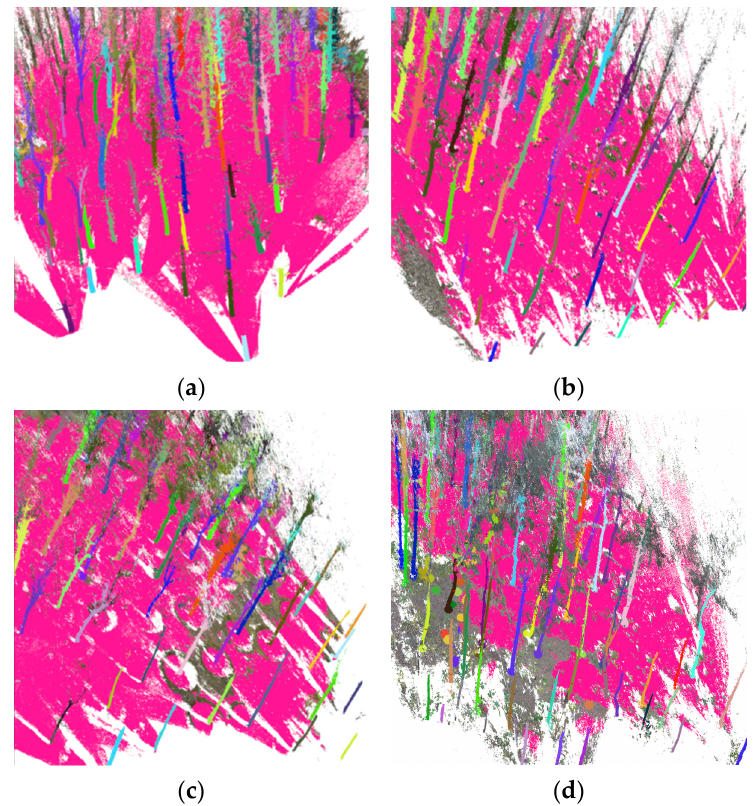
Figure 9. Result of terrain abstraction and tree segmentation. ( a ) Plot 1 (Beijing); ( b ) Plot 2 (Yinan); ( c ) Plot 3 (Beijing); ( d ) Plot 4 (Beijing). The ground is marked in magenta, and trees are marked in random colors.